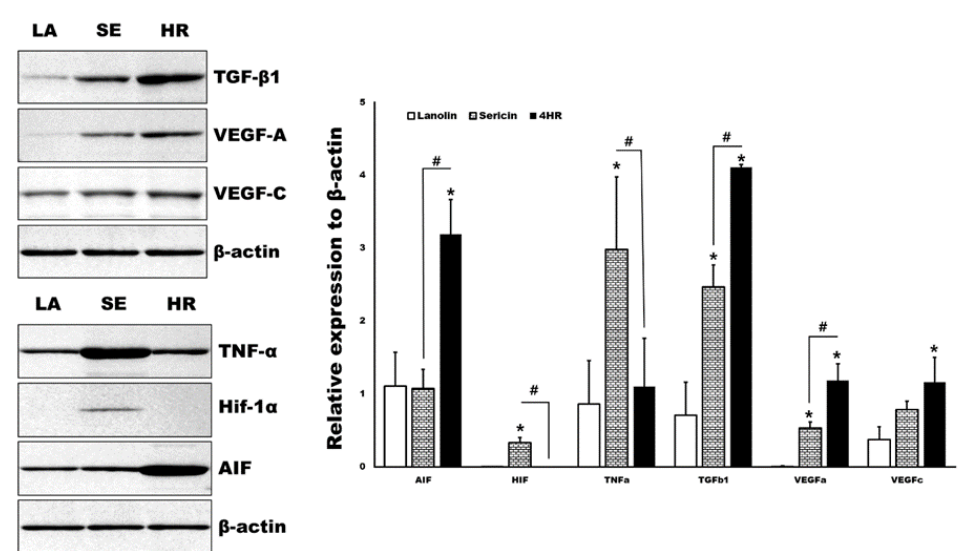
Figure 5. Western blot analysis for tissue samples. TGF-β1 and apoptosis-inducing factor (AIF) were significantly highly expressed in the 4HR-administered group (HR) compared to the ointment base only group (LA) and sericin-administered group (SE) ( p < 0.05). TNF-α and Hif-1α were significantly highly expressed in the SE group compared to the LA and HR groups ( p < 0.05). Full-length gels and blots are included in Figure S6. (TGF-β1: Transforming growth factor-β1, VEGF: Vascular endothelial growth factor, TNF-α: Tumor necrosis factor-α, Hif: Hypoxia-inducible factor, AIF: Apoptosis inducible factor. * p < 0.05 compared to LA group. # p < 0.05 between SE and HR group).